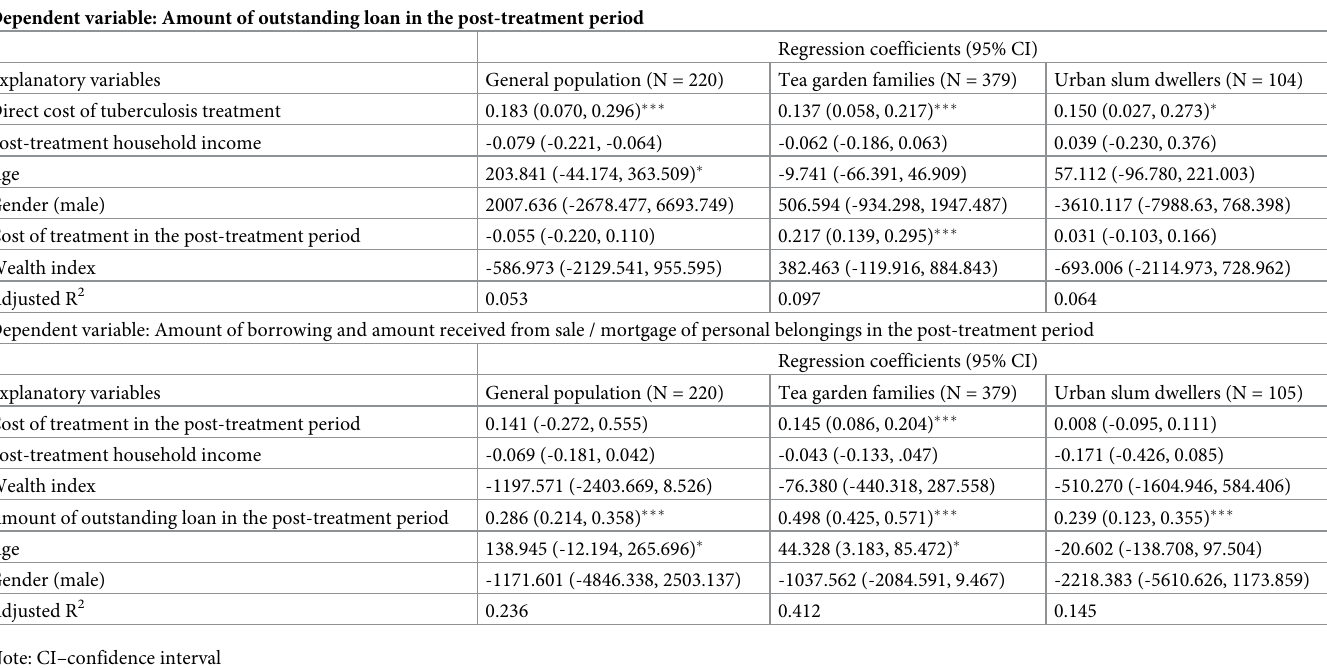
Table 7. Results of regression analysis of amount of outstanding loan and amount of borrowing /sale /mortgage of personal belongings during the post-treatment period. Dependent variable: Amount of outstanding loan in the post-treatment